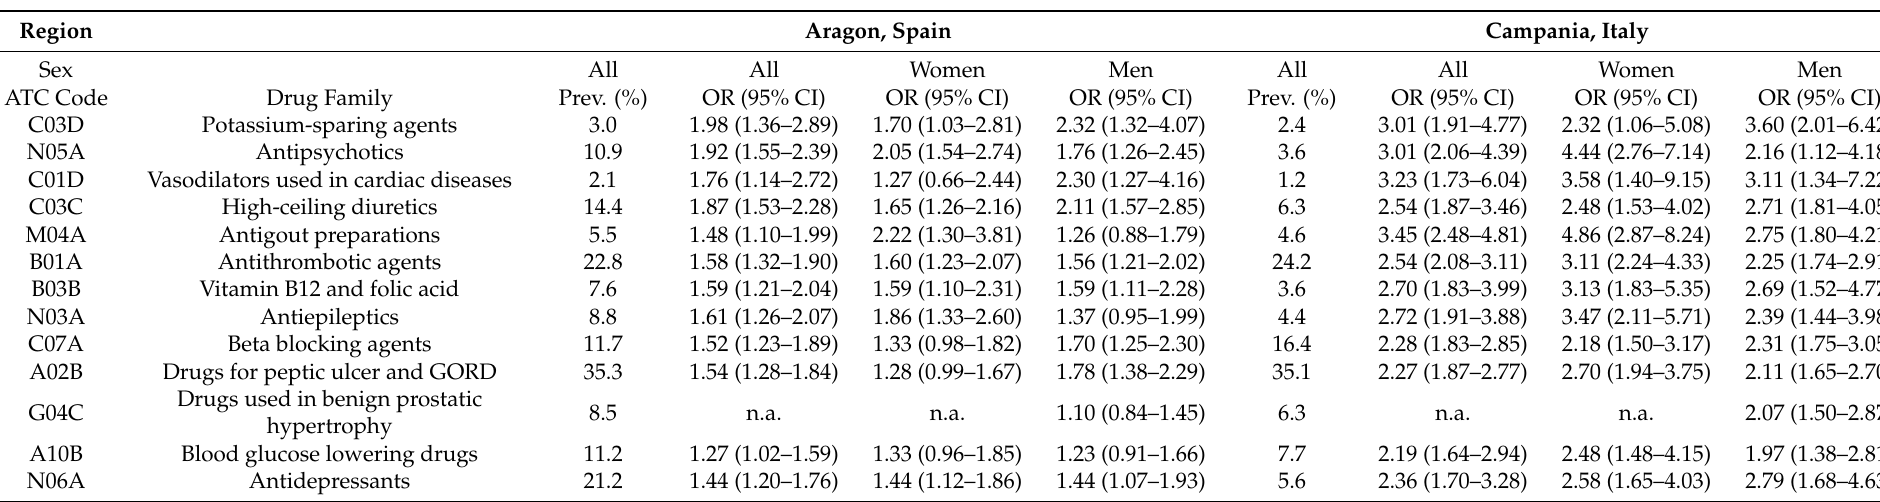
Table 3. Drug families in which dispensation within the three months prior to COVID-19 infection was consistently associated with 30-day mortality in patients from both regions studied. Region Aragon, Spain Campania, Italy Sex All All